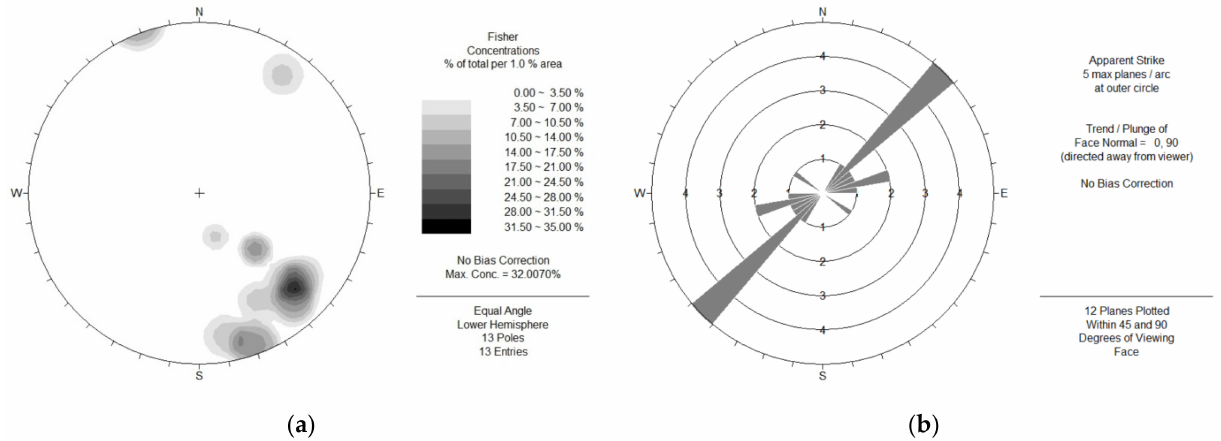
Figure 3. ( a ) Contour plot; ( b ) rosette plot.